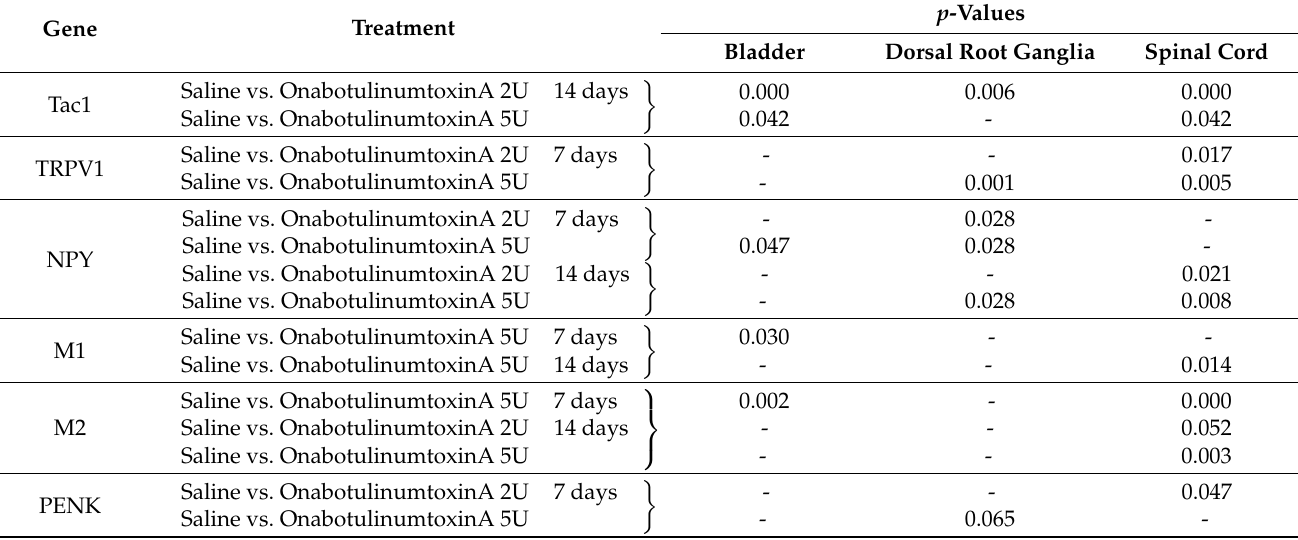
Table 1. p -values of statistically significant results of gene expression analysis by real-time PCR.